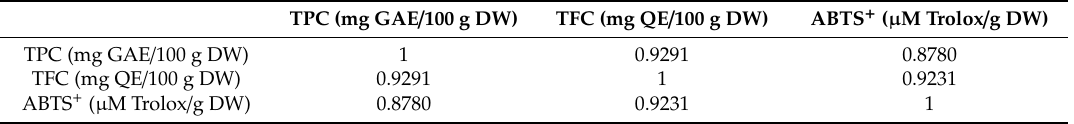
Table 2. Cross-correlation between TPC, TFC, and antioxidant activity of mushrooms extracts.